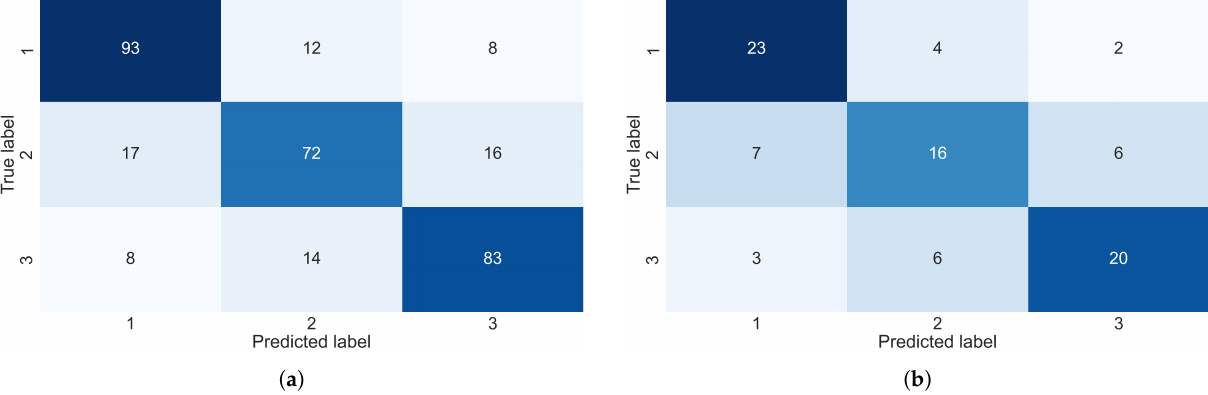
Figure 19. Confusion matrices for the REFIT dataset and the UCID dataset. ( a ) Confusion matrix—UCID. ( b ) Confusion matrix—REFIT.